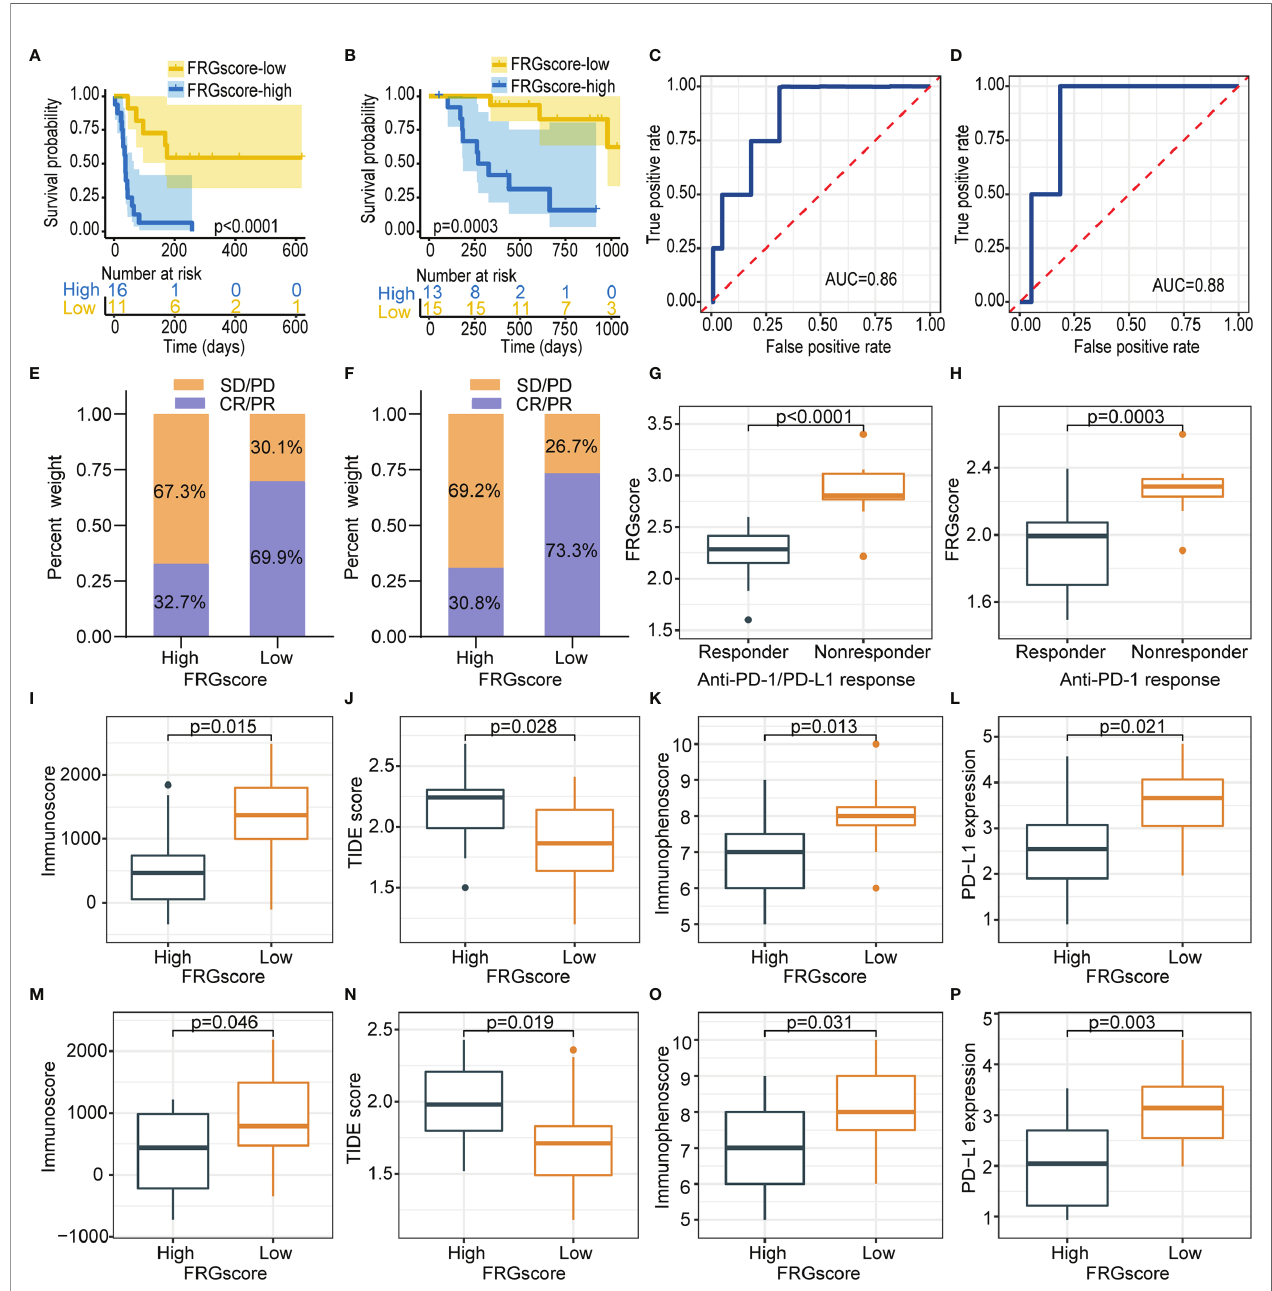
FIGURE 8 | FRGscore is an effective predictor of immunotherapeutic bene fi ts. (A, B) Kaplan – Meier curves of GSE135222 cohort (A) and GSE78220 cohort (B) in FRGscore-high and FRGscore-low subgroups. (C, D) ROC curve of FRGscore in predicting immunotherapeutic response in GSE135222 cohort (C) and GSE78220 cohort (D) . (E, F) Proportion of patients with positive clinical response to anti-PD-1/PD-L1 immunotherapy in FRGscore-high or FRGscore-low subgroups in GSE135222 cohort (E) and GSE78220 cohort (F) . (G, H) Distributions of FRGscore in distinct response status to anti-PD-1/PD-L1 immunotherapy in GSE135222 cohort (G) and GSE78220 cohort (H) . (I – L) Distributions of immunoscore (I) , TIDE score (J) , immunophenoscore (K) , and PD-L1 expression level (L) in FRGscore-high and FRGscore-low subgroups in GSE135222 cohort. (M – P) Distributions of immunoscore (M) , TIDE score (N) , immunophenoscore (O) , and PD-L1 expression level (P) in FRGscore-high and FRGscore-low subgroups in GSE78220 cohort. FRGscore, ferroptosis-related gene score; ROC, receiver operating characteristic; TIDE, Tumor Immune Dysfunction and